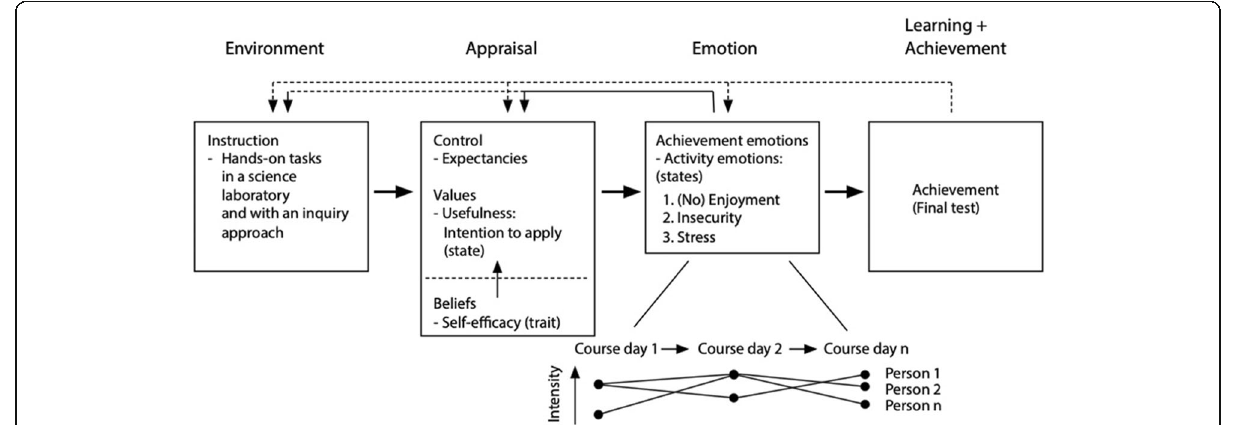
Fig. 1 Control-Value model of achievement emotions by Pekrun (2006) adapted for our